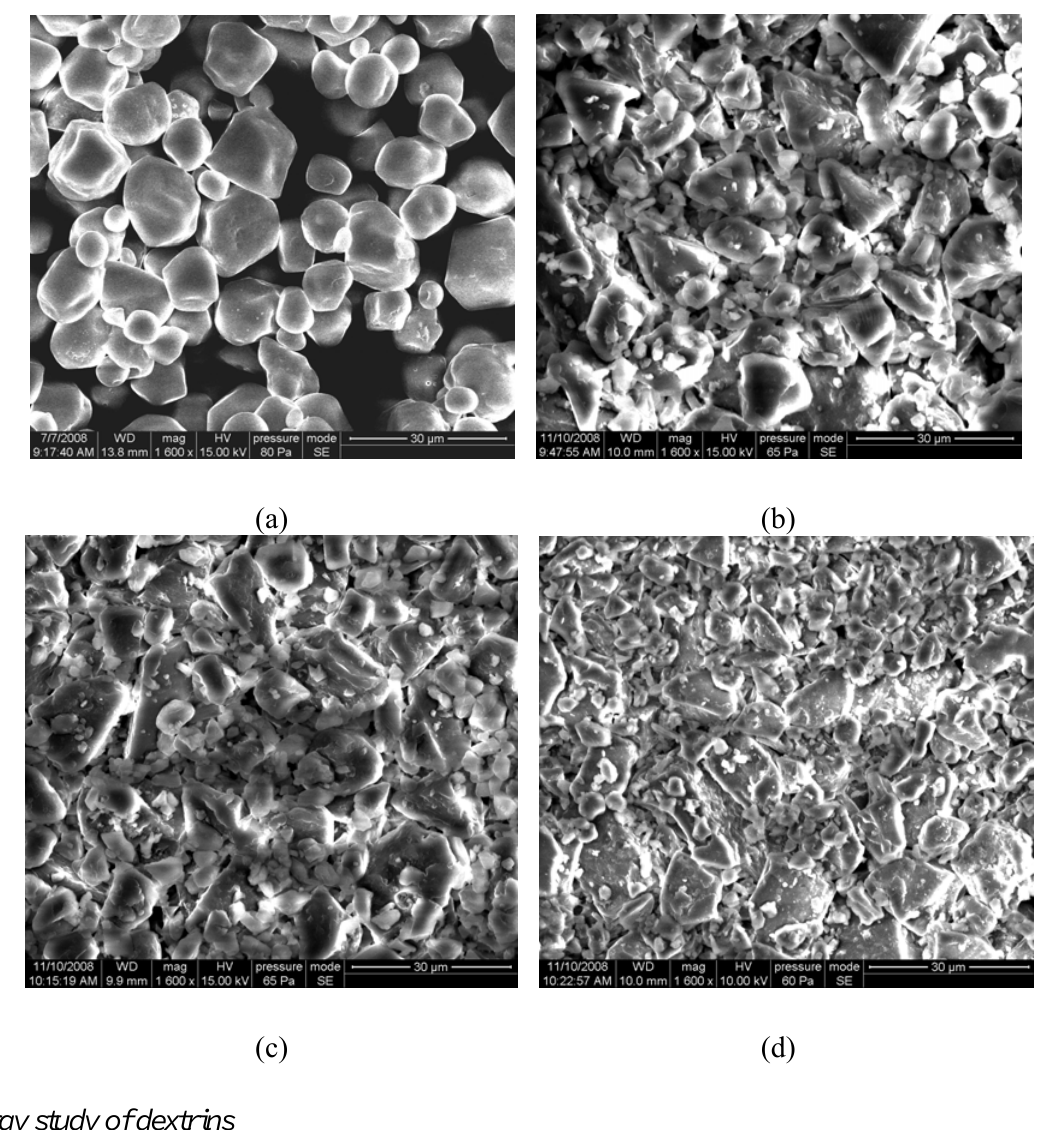
Figure 1. SEM photographs of the starch and the dextrins: (a) native starch; (b) dextrin (DE 9); (c) dextrin (DE 15); (d) dextrin (DE